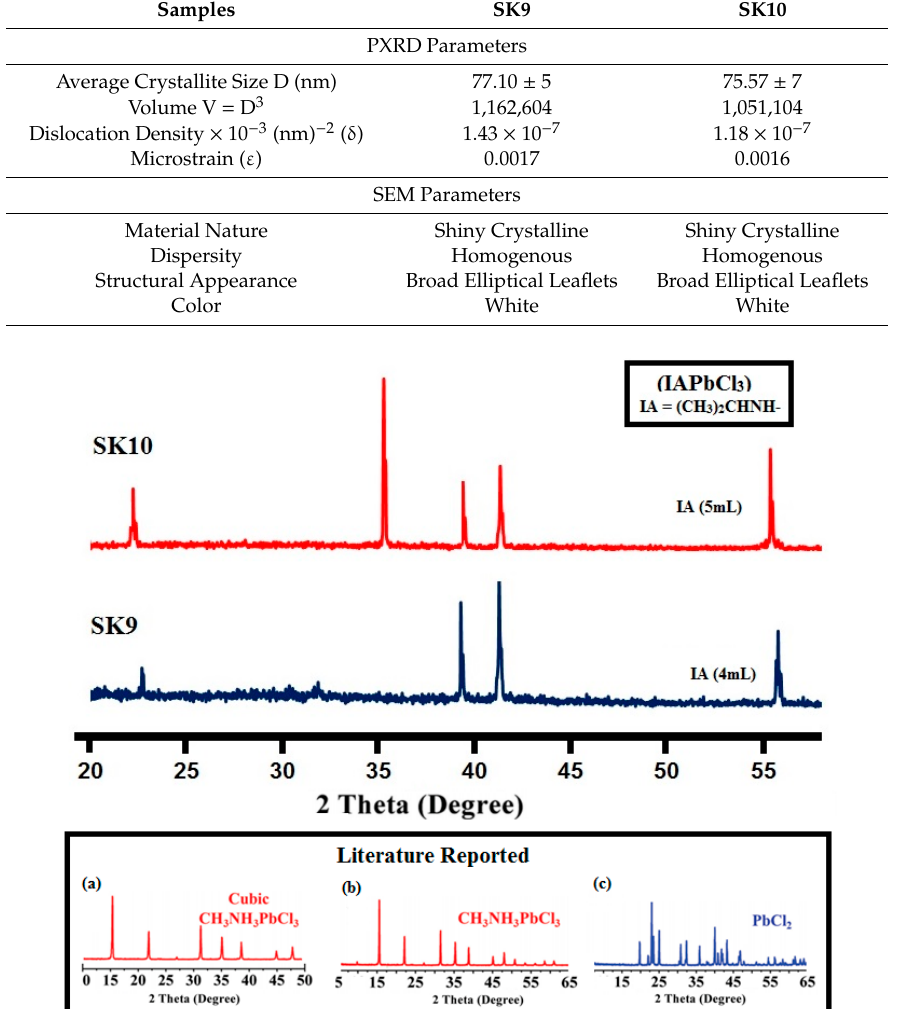
Figure 1. PXRD pattern of synthesized IAPbCl 3 perovskite nanomaterials ( SK9 – SK10 ); Literature reported PXRD patterns of some methyl amine lead chloride perovskites are given in ( a ) and ( b ) and PbCl 2 in ( c )